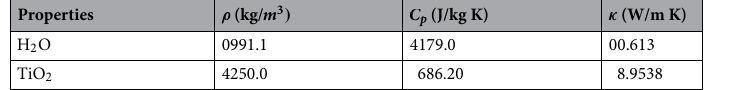
Table 1. Thermophysical properties model of titanium dioxide and water nanofluid 40 .